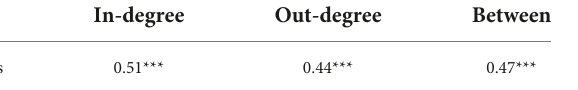
TABLE 5 Correlations between interpersonal self-efficacy and friendship network scale. In-degree Out-degree Between